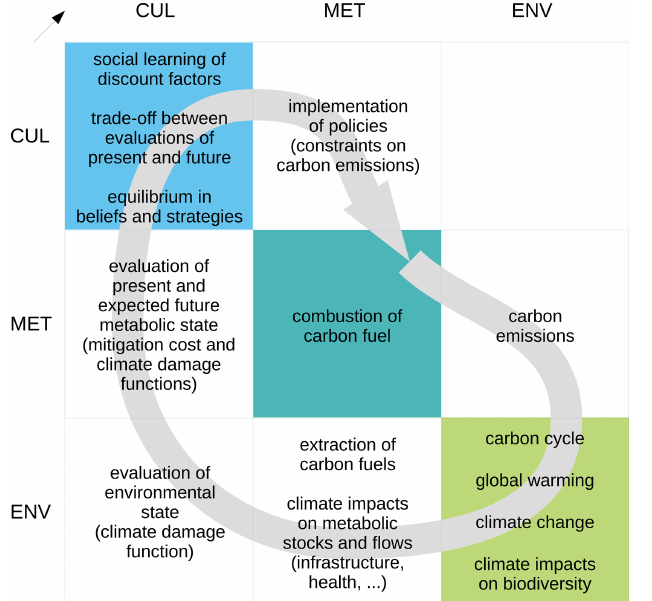
Figure 3. Planetary social–ecological processes and interactions represented in the copan:DISCOUNT model displayed in matrix form following Fig. 2. The co-evolutionary cycle of dynamic in- terdependencies implemented in the model is indicated by the grey